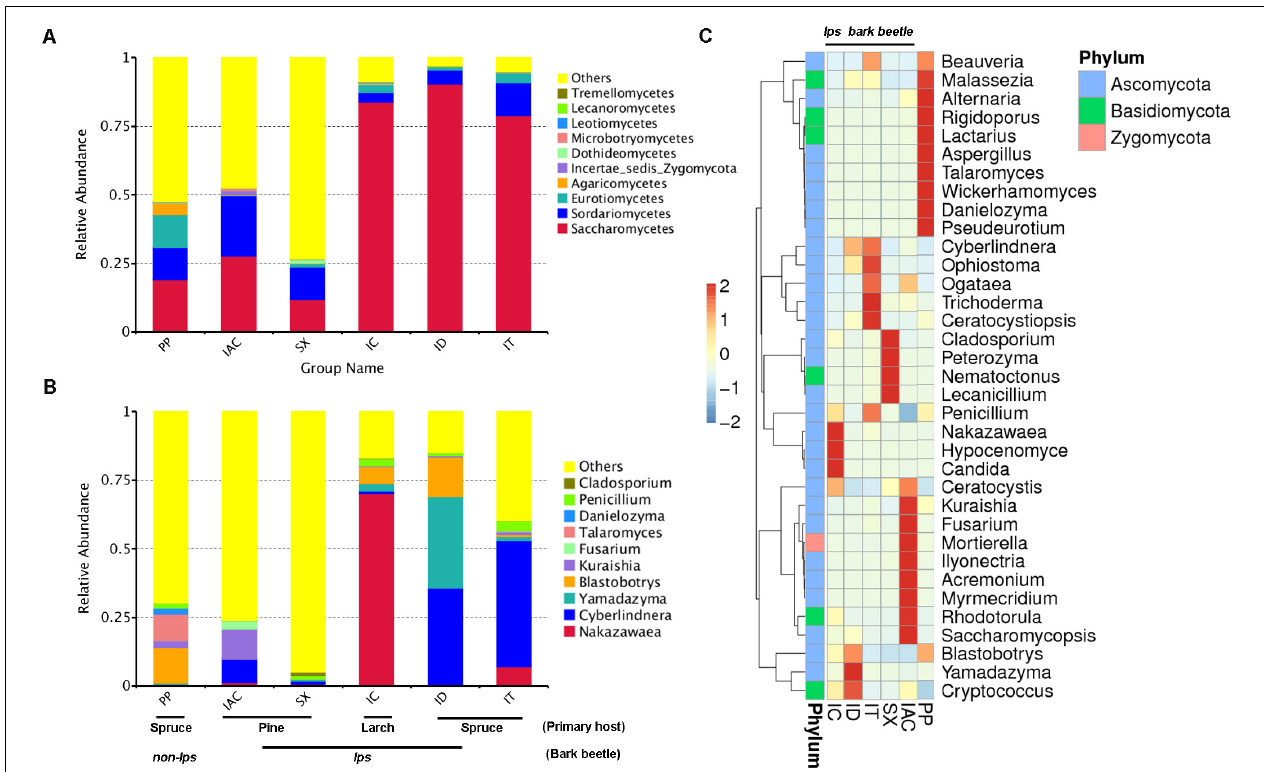
FIGURE 2 | Fungal diversity observed in the gut of different bark beetles. (A) The bar plot illustrating the relative abundance of the gut mycobiome at the class level (top 10). “Others” signifies the total relative abundance of the rest of the class. (B) The histogram depicting the relative abundance of top 10 fungal genera in the bark beetle gut. Likewise, “Others” represents the total relative abundance of rest of the fungal communities in the beetle gut. (C) Heatmap displaying the abundance of 35 dominant fungal genera in the gut of the bark beetles. The color gradient shows the relative OTU abundance for each bark beetle where the darker color signifies higher abundance and lighter color indicates a low abundance of the particular fungal